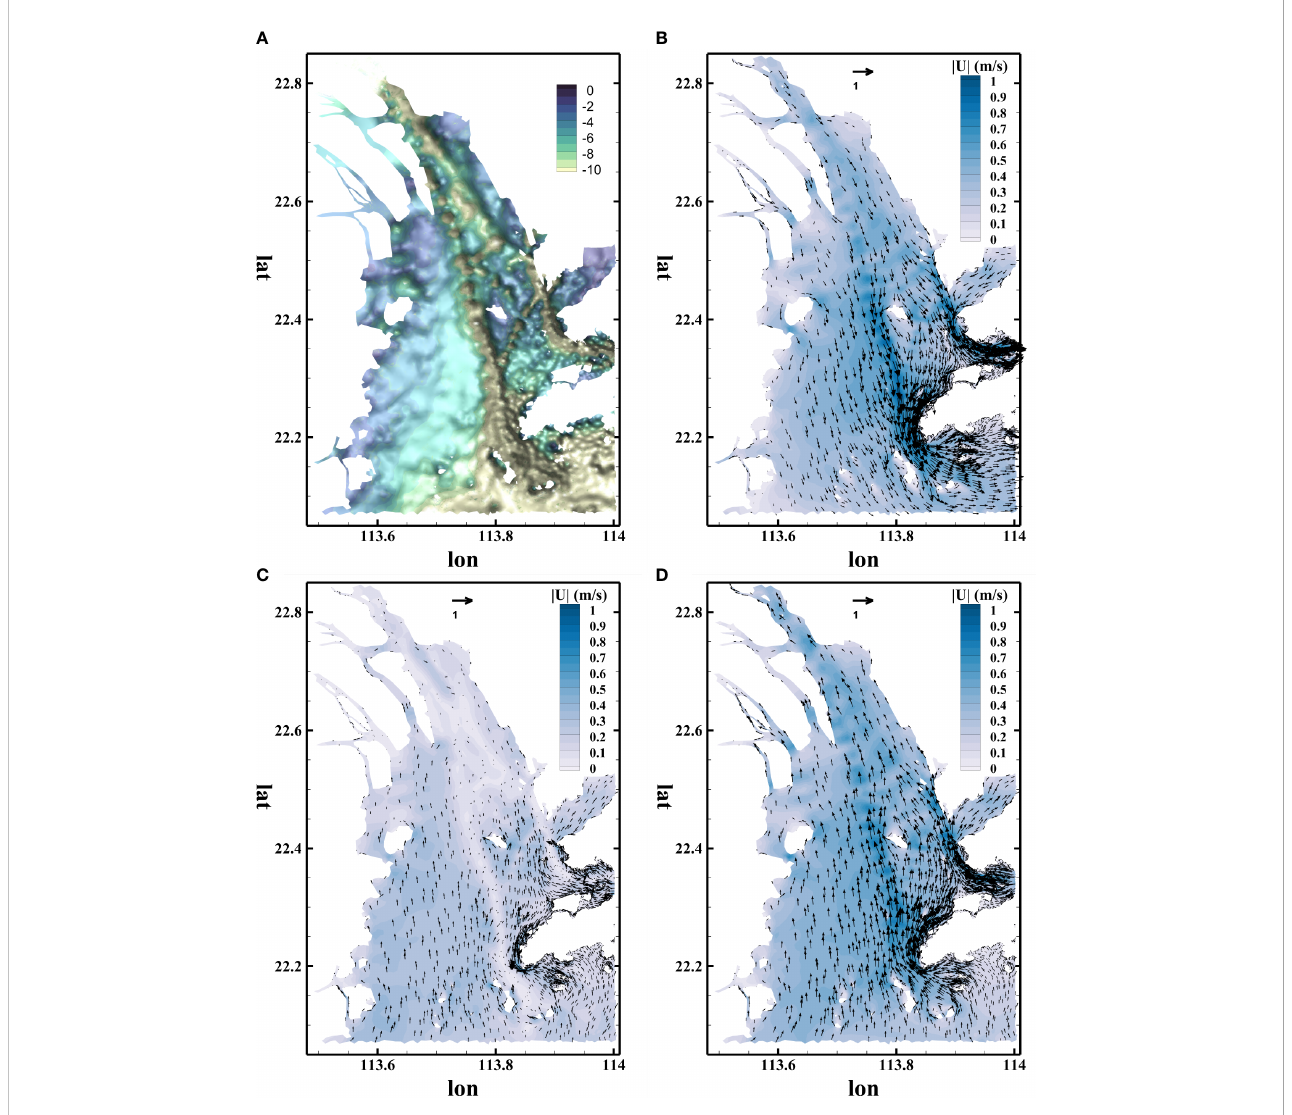
FIGURE 2 Examples of velocity fi eld during different phases of tidal cycles. Bathymetry in the Pearl River Estuary (PRE) (A) and the contour indicating the water depth. Velocity fi eld of surface layer during ebb tide (B) , surface elevation equaling zero (C) , and fl ood tide (D) . Arrows represent velocity magnitude and direction of speci fi c nodes, and contour represents absolute velocity